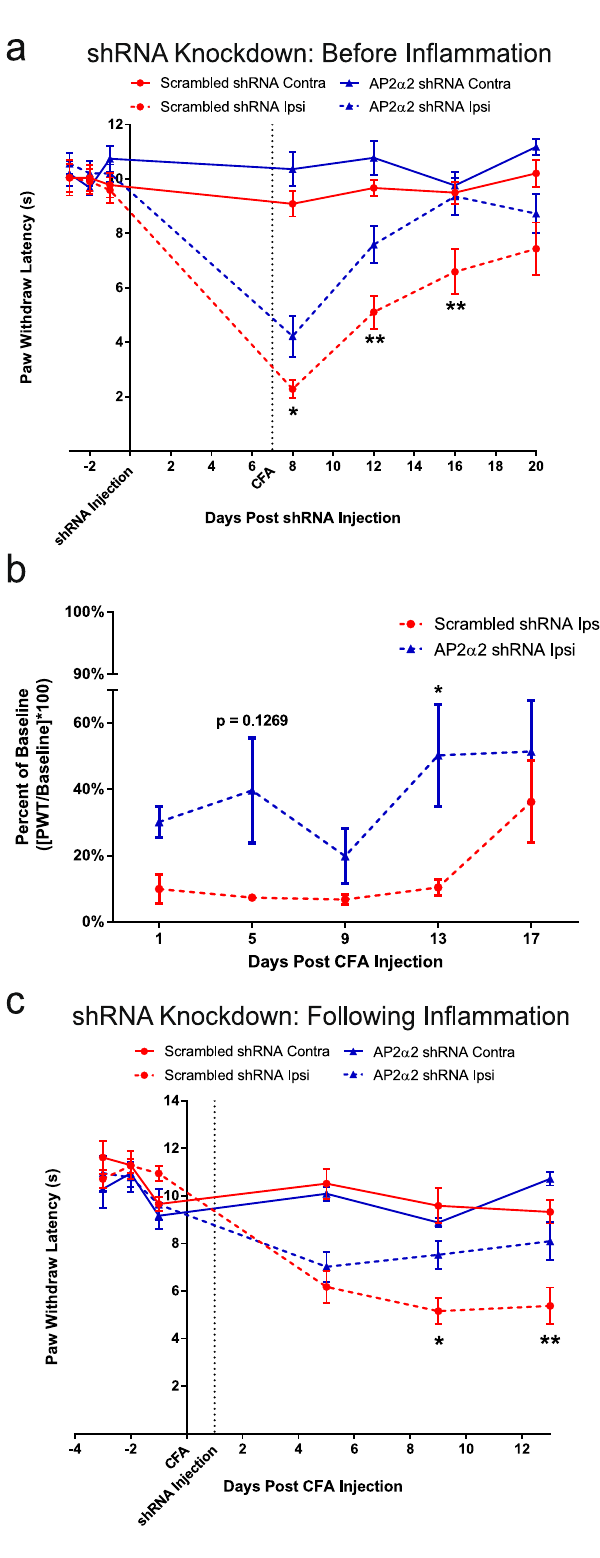
thresholds (Fig. 4g). Using a dynamic weight bearing apparatus,